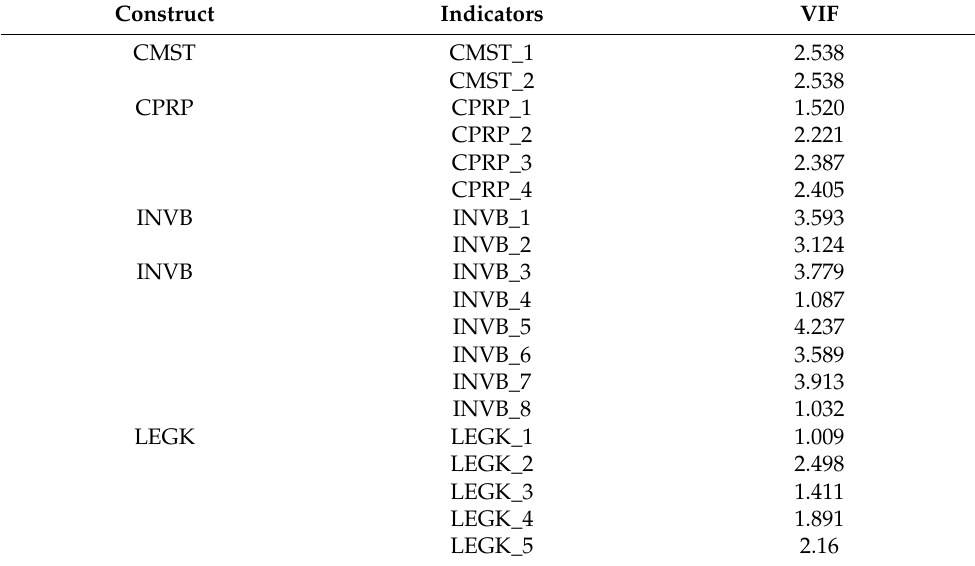
Table 5. Results for variance inflation